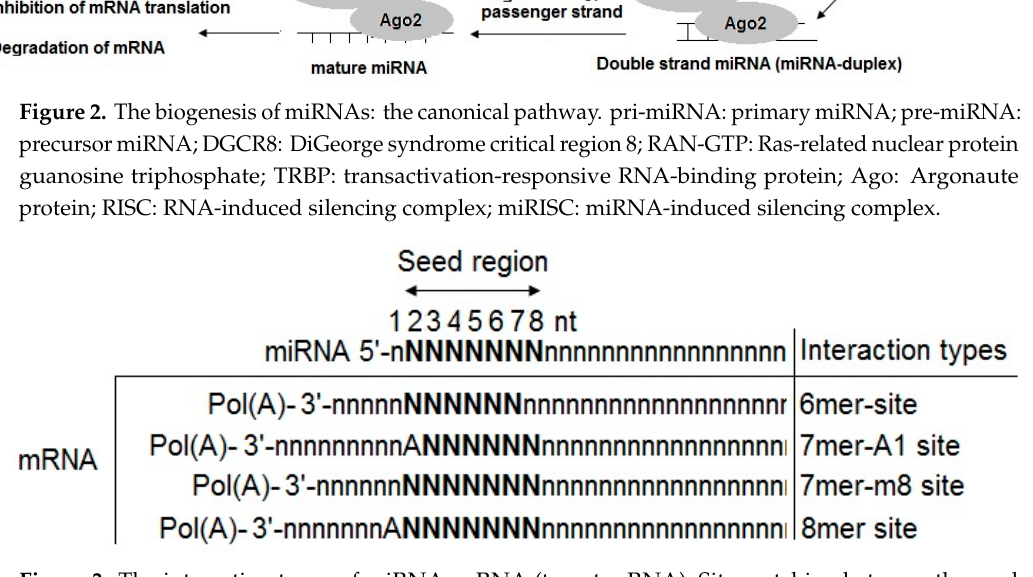
Figure 3. The interaction types of miRNA–mRNA (target mRNA). Site matching between the seed region of miRNA (at positions 2–8) and the 3 (cid:48) -end of the target mRNA. The character of N represents the single Watson–Crick paring nucleotide. Pol(A): Poly-A tail; A: